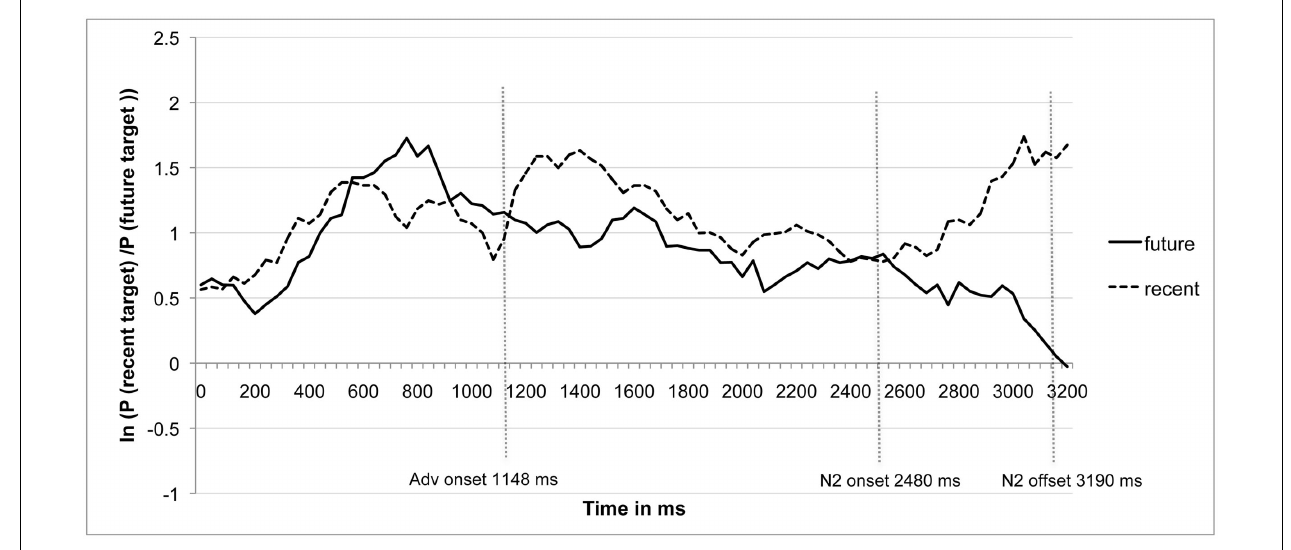
FIGURE 2 | Mean log gaze probability ratios ln (P(recent target)/P(future target)) as a function of condition fromVerb Onset for Experiment 1.